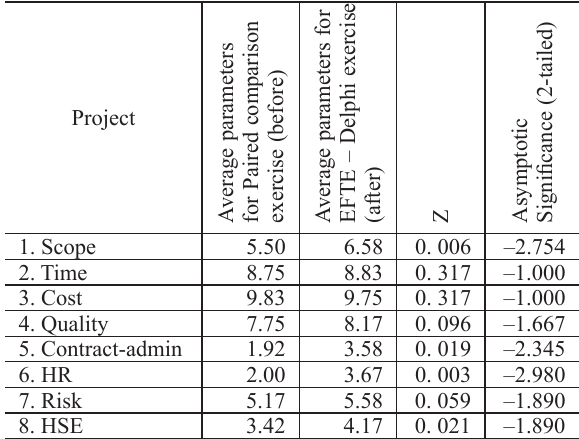
Table 6. Wilcoxon test to establish statistical significance of introduction of local knowledge